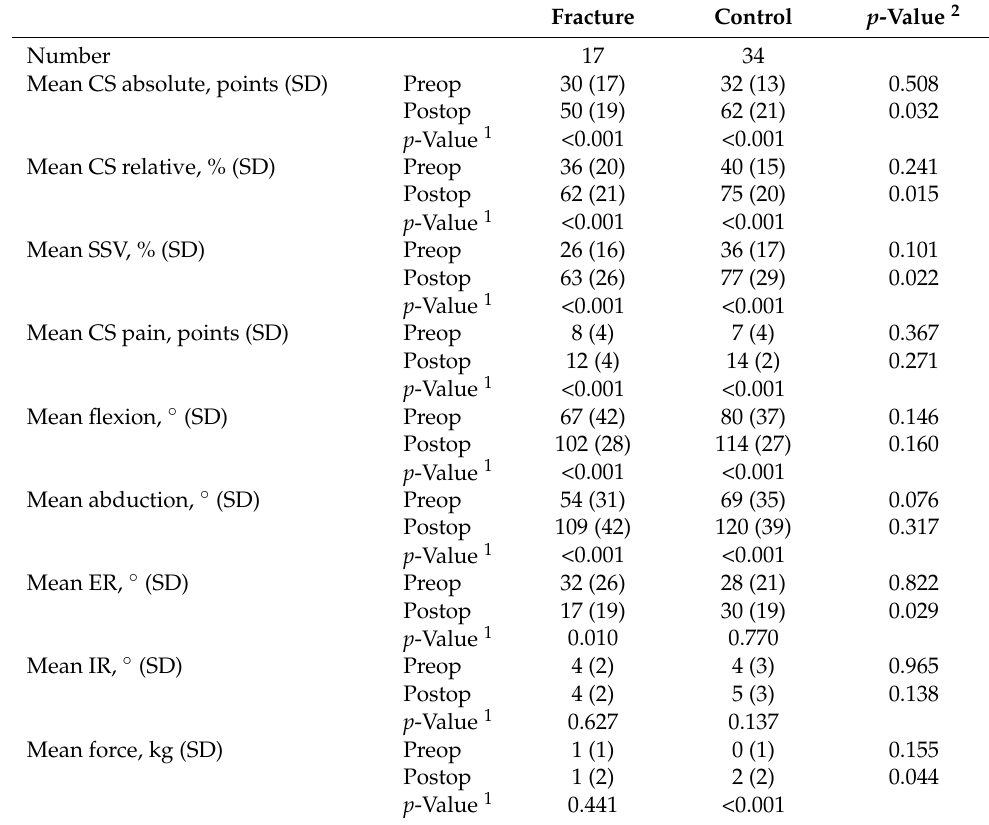
Table 3. Clinical outcome comparing greater tuberosity fracture following RTSA with the control group. Wilcoxon-Ranksum testing 1 and Mann-Whitney-U testing 2 were used to compare the groups. Abbreviations: CS, Constant Score; ER, External rotation; FUP, Follow-up; IR, internal rotation; kg, kilograms; SD, Standard deviation; SSV, Subjective Shoulder